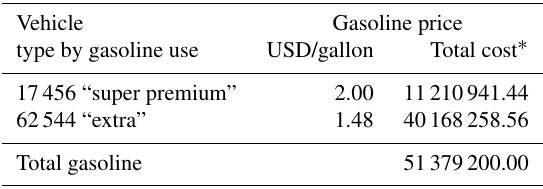
Table 4. Vehicle type and different gasoline prices in USD.